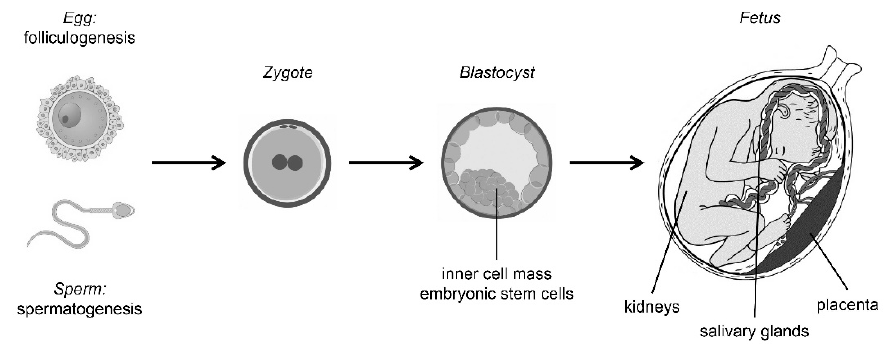
Figure 2. Developmental functions of TFCP2/TFCP2L1/UBP1 transcription factors.